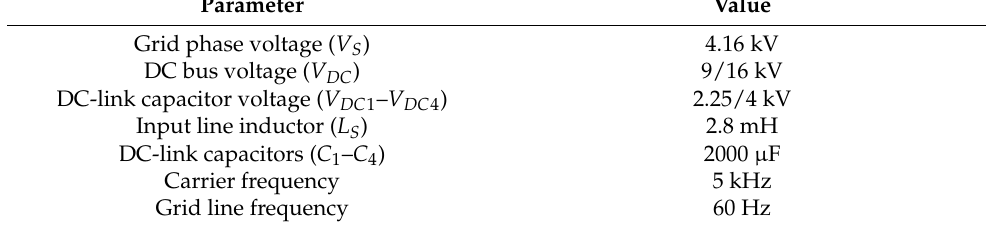
Table 3. Parameters of the simulation system.